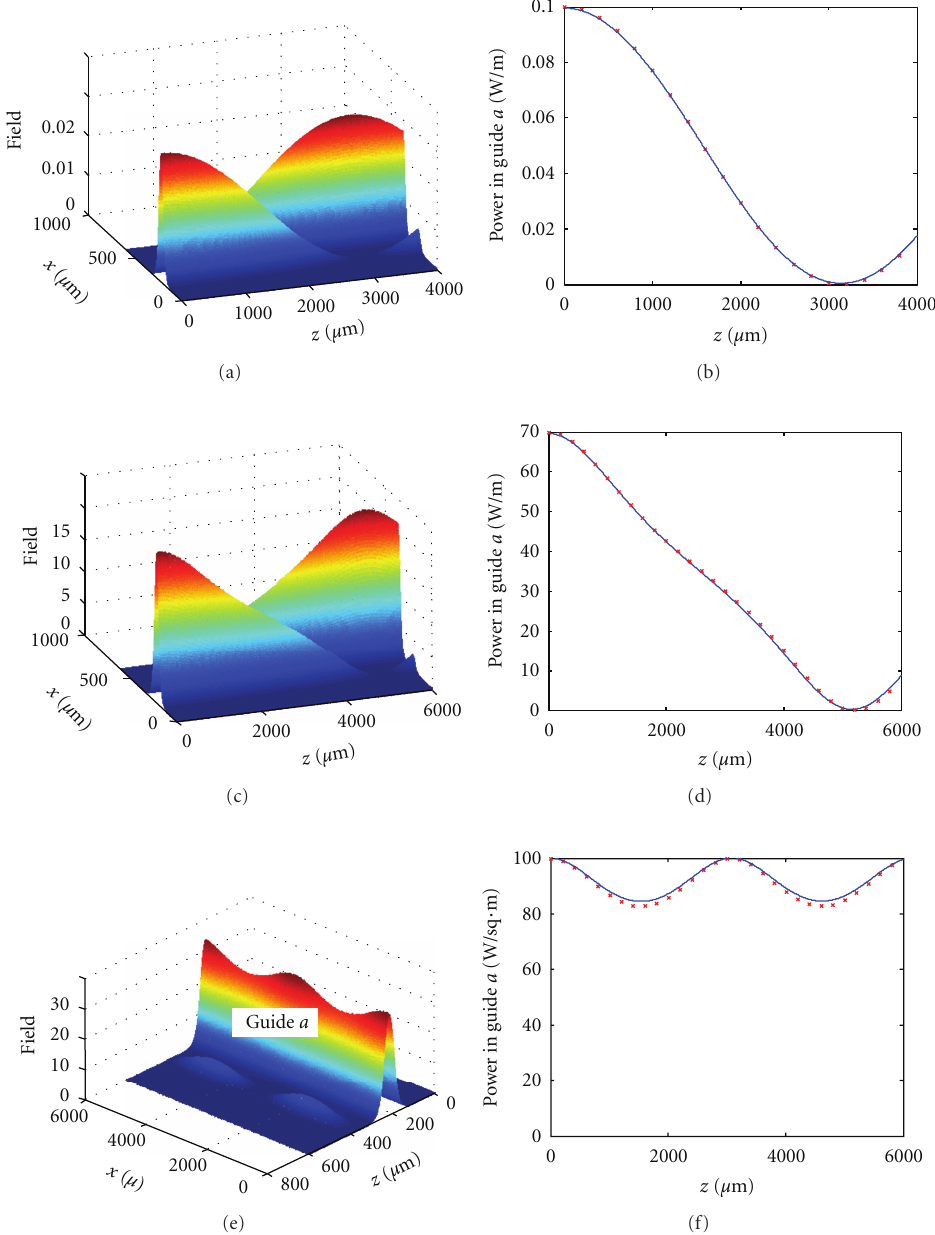
Figure 4: (a) Field evolution at 0.1 W/m input power: BPM. (b) Power flow pattern, (line curve) computed from BPM shown left, (crossed points) coupled mode theory. (c) Field evolution at 70 W/m power: BPM. (d) Power flow pattern (line curve), computed from BPM shown left, (crossed points) coupled mode theory fitted. (e) Field evolution at 100 W/m power: BPM. (f) Power flow pattern, (line curve) computed from BPM shown left, (crossed points) coupled mode theory